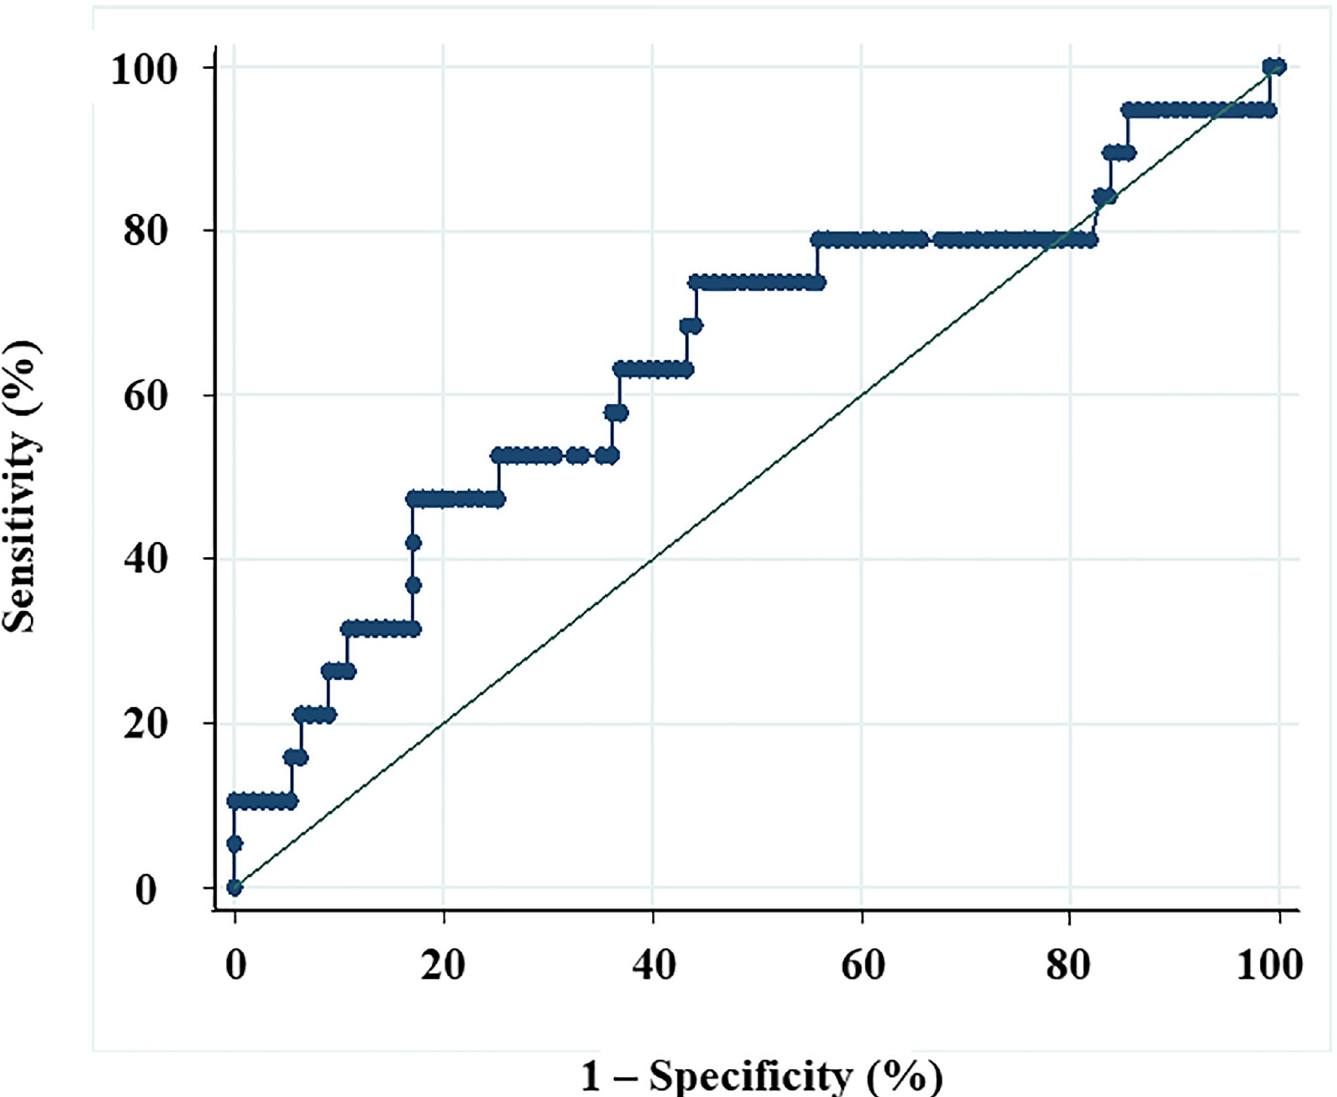
Fig 2. ROC curve for the use of the aspartate aminotransferase-to-platelet ratio index (APRI) as a biomarker to diagnose patients at risk of severe malaria due to P . vivax infection. A cutoff of 0.74 yielded a sensitivity of 74.0%, specificity of 56.0%, and accuracy of 65.0%.